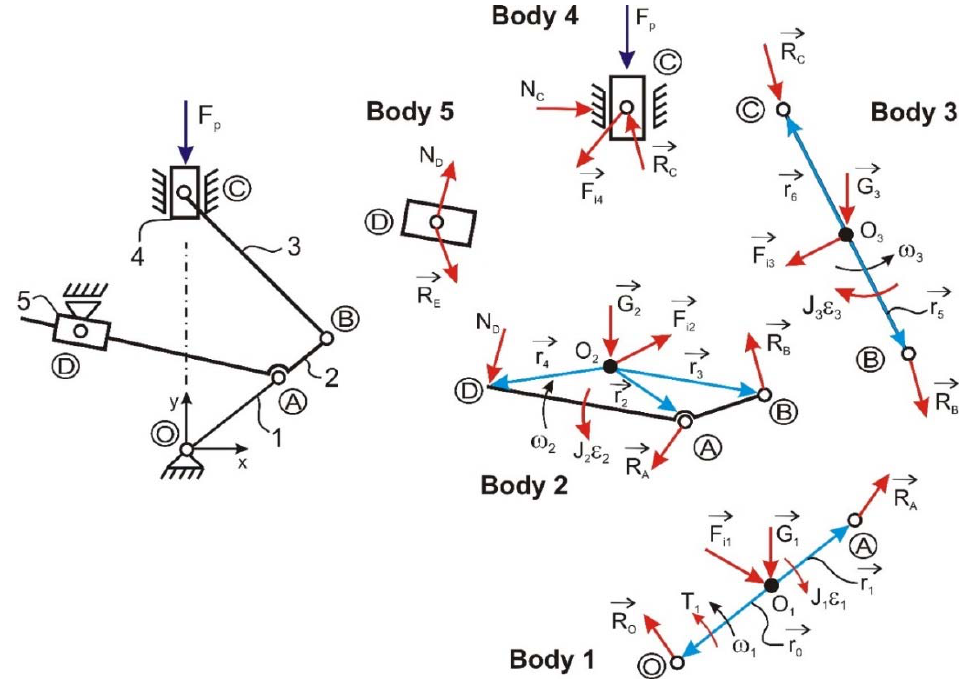
Figure 9. Free body diagram for the mechanism with oscillating arm—VCR.